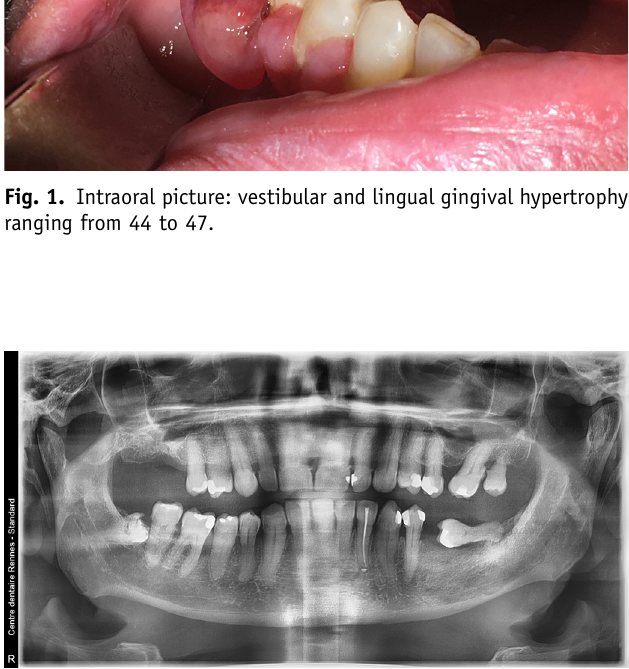
Fig. 2. Orthopantomogram: periodontal pocket mesial to tooth 46.